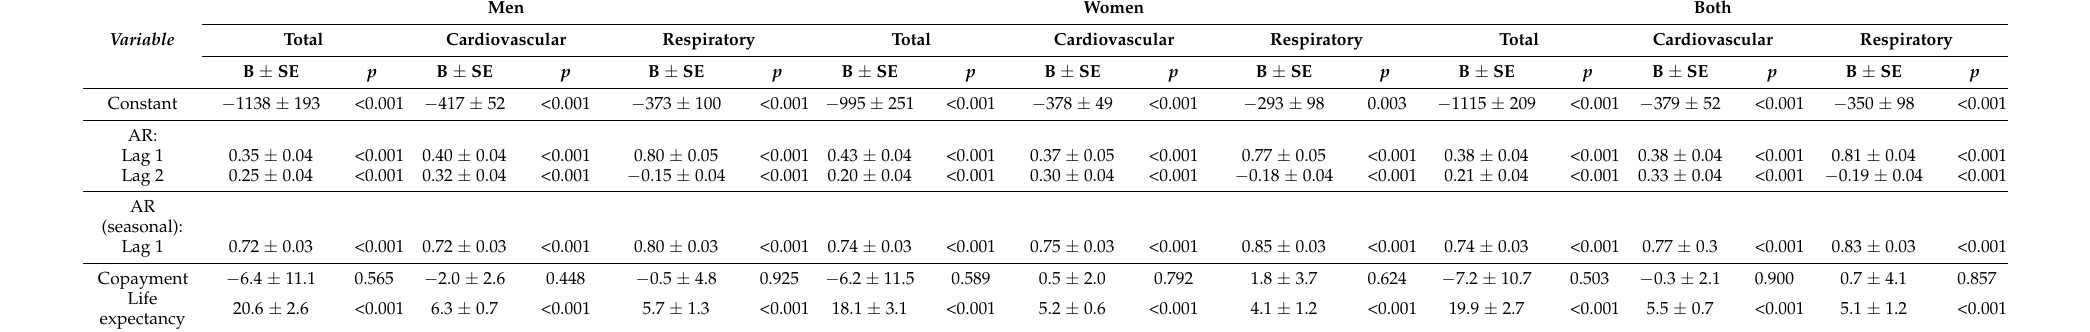
Abbreviations: B, coefficient; SE, standard error. All the results were adjusted for life